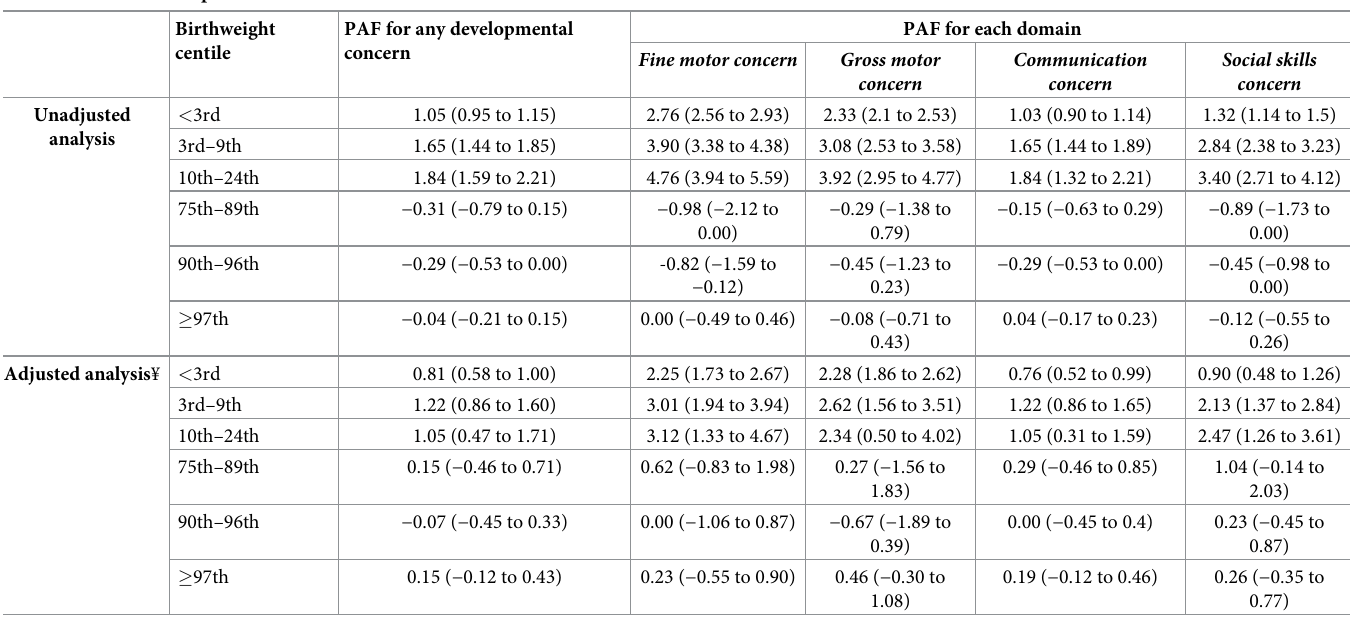
Table 3. PAFs of developmental